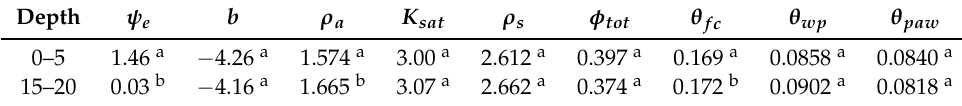
Table 3. Hydraulic and soil physical properties for irrigated land use in different